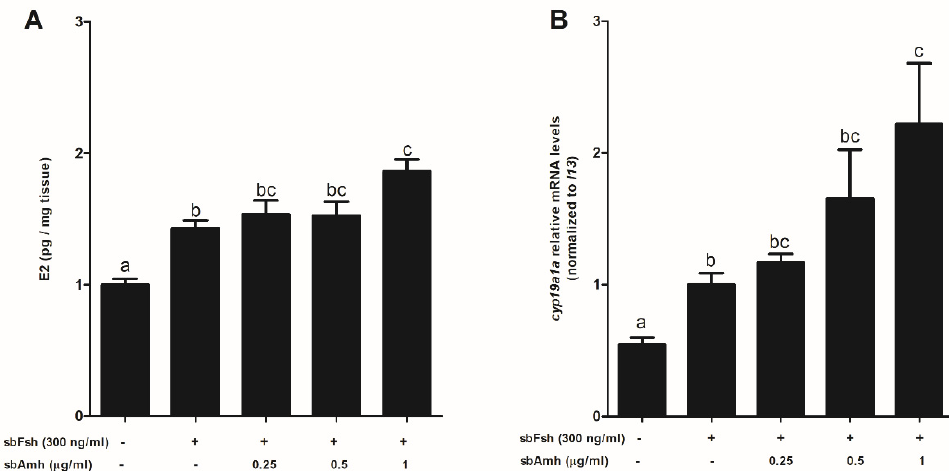
Figure 7. In vitro effect of sea bass Amh and sea bass Fsh on ( A ) E2 levels and ( B ) cyp19a1a expression in previtellogenic/early-vitellogenic sea bass ovarian explants. Data are shown as the means ± SEM and correspond to four separate experiments ( n = 4) with 6 different replicates each and were analyzed by ANOVA followed by Tukey’s significant interaction test. Statistical differences ( p < 0.05) are indicated with different letters above the bars.